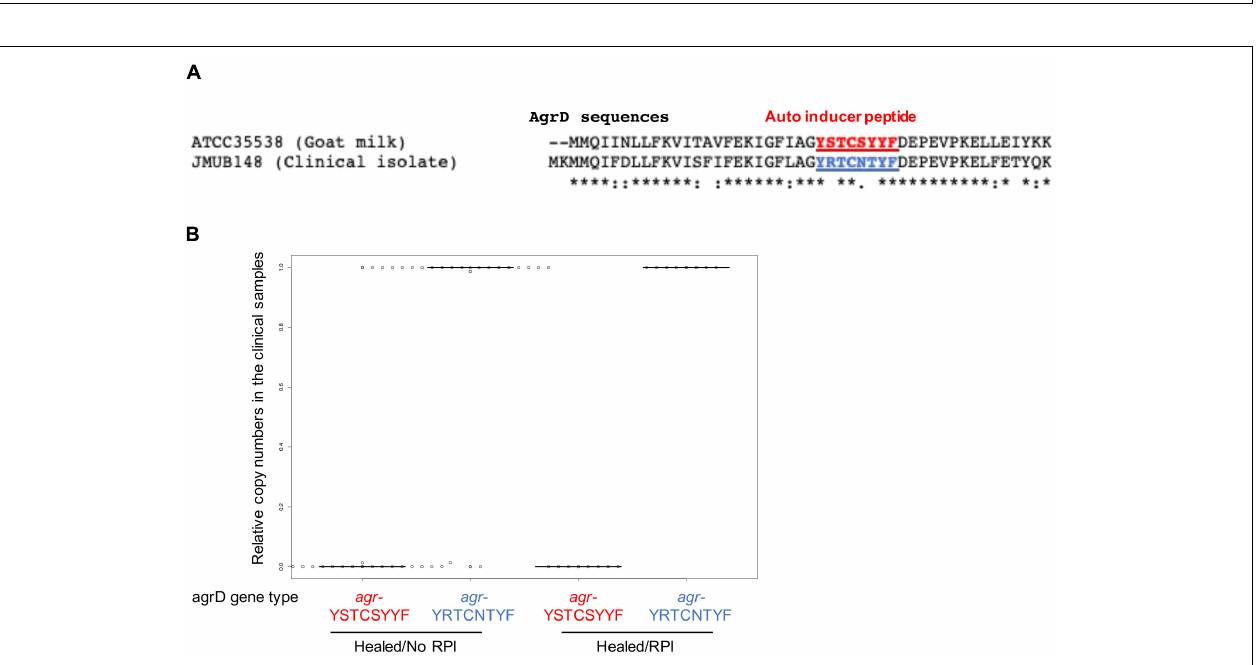
FIGURE 4 | Staphylococcus caprae typing by AgrD genes in the clinical samples. (A) Different amino acid sequences of AgrD from ATCC 35538 (goat milk) and JMUB145 (clinical isolate), although mature structures of the peptides have not been confirmed yet. (B) Copy numbers were calculated by probe qPCR using the serial dilution of purified chromosomal DNAs of ATCC 35538 ( agrD _YSTCSYYF) and JMUB145 ( agrD _YRTCNTYF). Relative copy numbers were calculated as ( agrD _YSTCSYYF or agrD _YRTCNTYF copy numbers)/[( agrD _YSTCSYYF copy numbers) + ( agrD _YRTCNTYF copy numbers)].